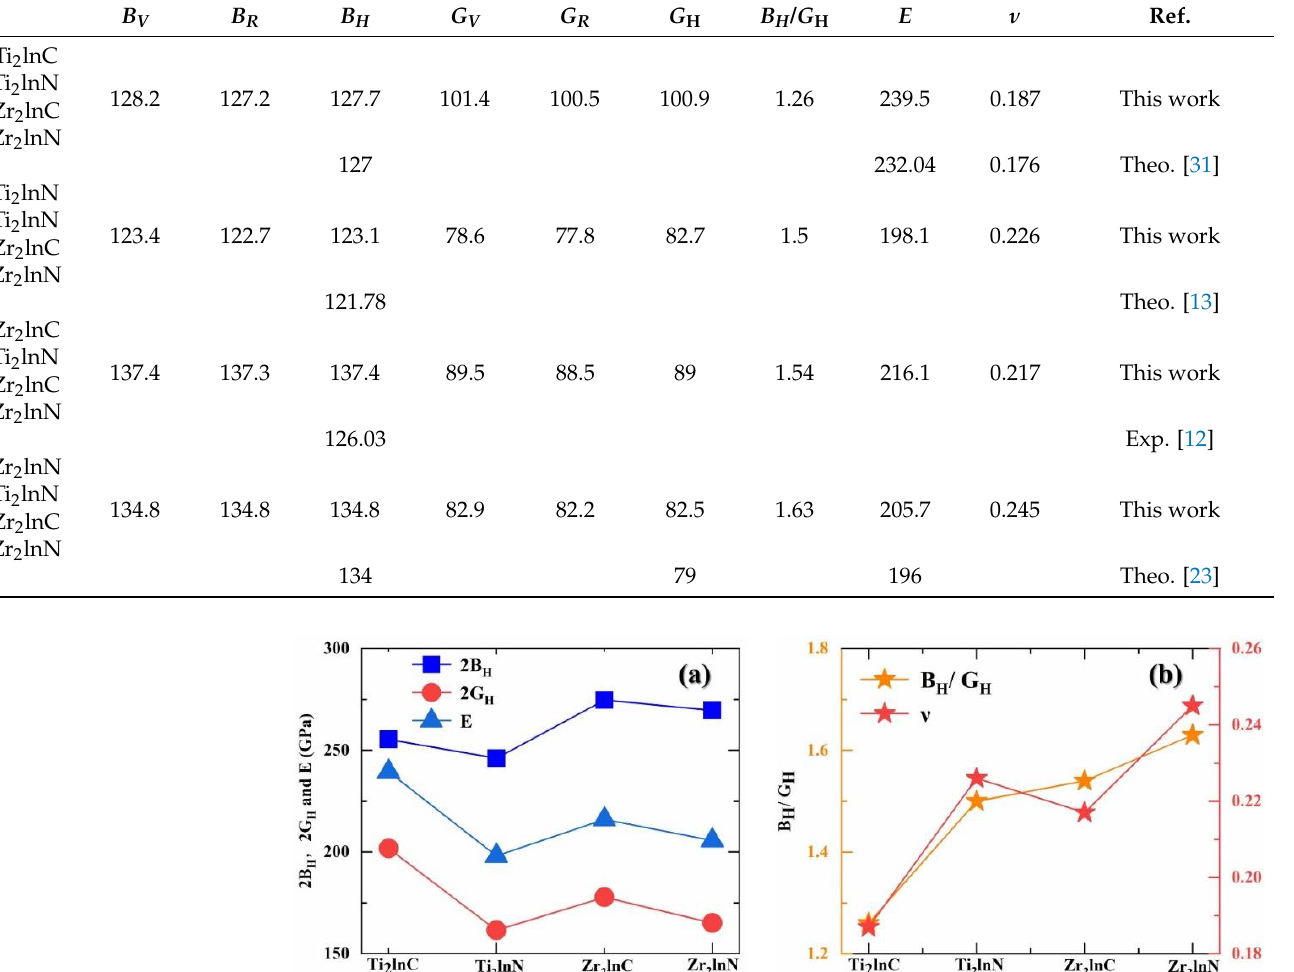
Table 3. Calculated bulk modulus B (in GPa), shear modulus G (in Gpa), Poisson’s ratio ν , and Young’s modulus E (in GPa) of M 2 InX (M = Ti, Zr and X = C, N) MAX phases. B V B R